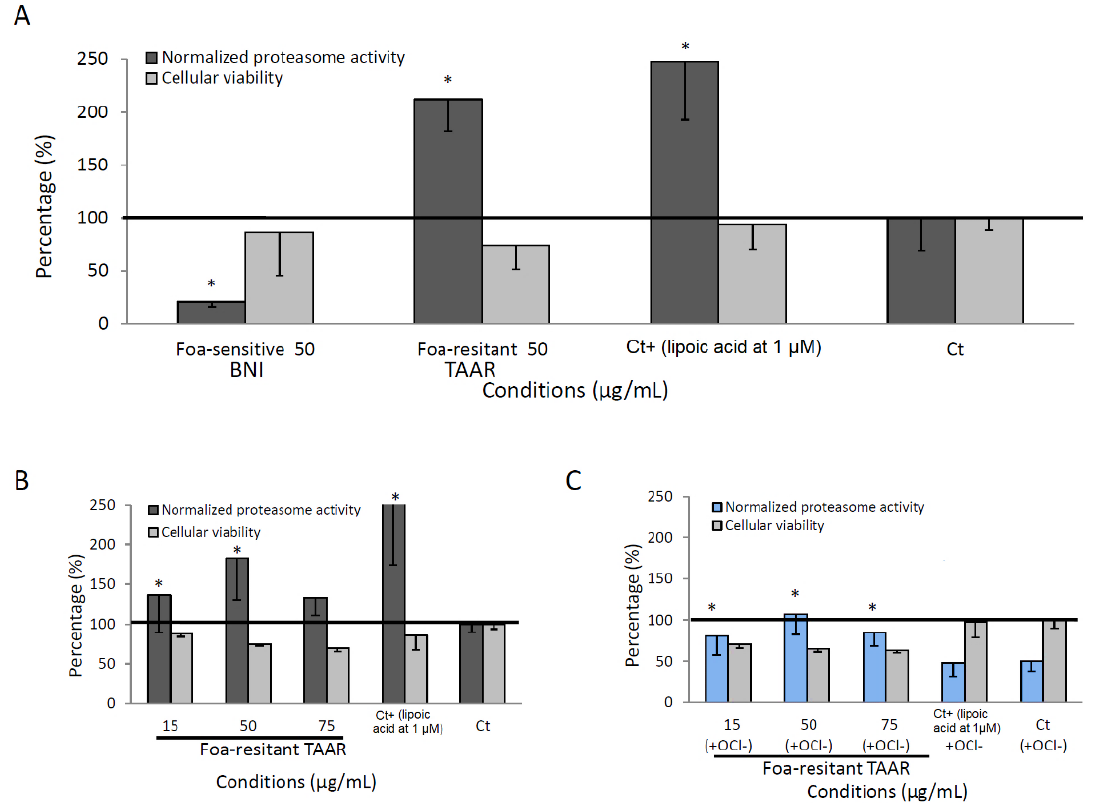
Figure 2. Proteasome activities. ( A ) Determination of the effects of the plant methanolic extracts on the proteolytic activity of the proteasome in human NHDF-aged cells treated with a 50 µ g/mL con- centration ( B ) or with an increasing concentration of TAAR extract. ( C ) Ability of TAAR methanolic extracts to reverse the proteasome inhibition by the OCl − oxidant. Lipoic acid (1 µ M) was used as a reference compound. The data are presented as mean (SD) values for each experimental condition (n = 3), and a nonparametric Mann–Whitney test analysis was employed to compare the statistical difference between extracts: the stars show a significant difference between control (Ct) and other conditions. * Indicates statistically significant differences as compared to controls ( p < 0.05).